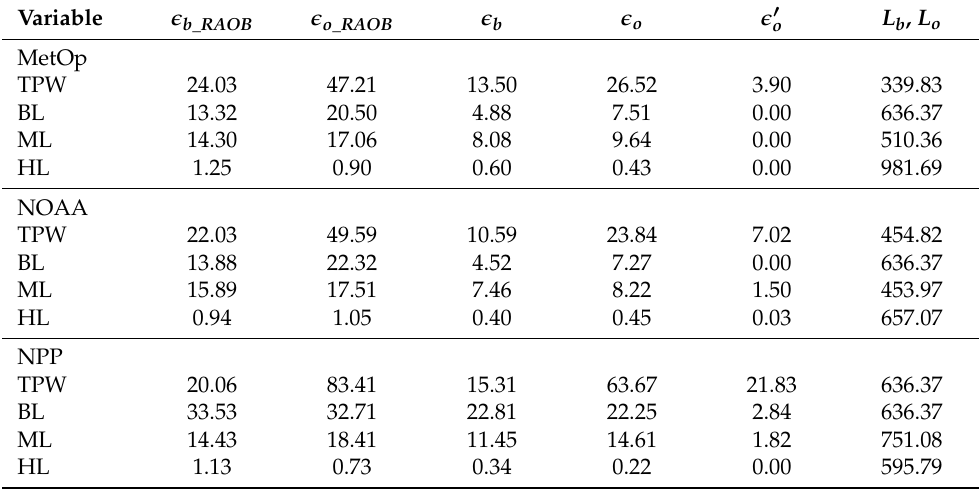
Table 2. July 2016 correlation length scales and error variances for MetOp-A,B, NOAA-18,19, and